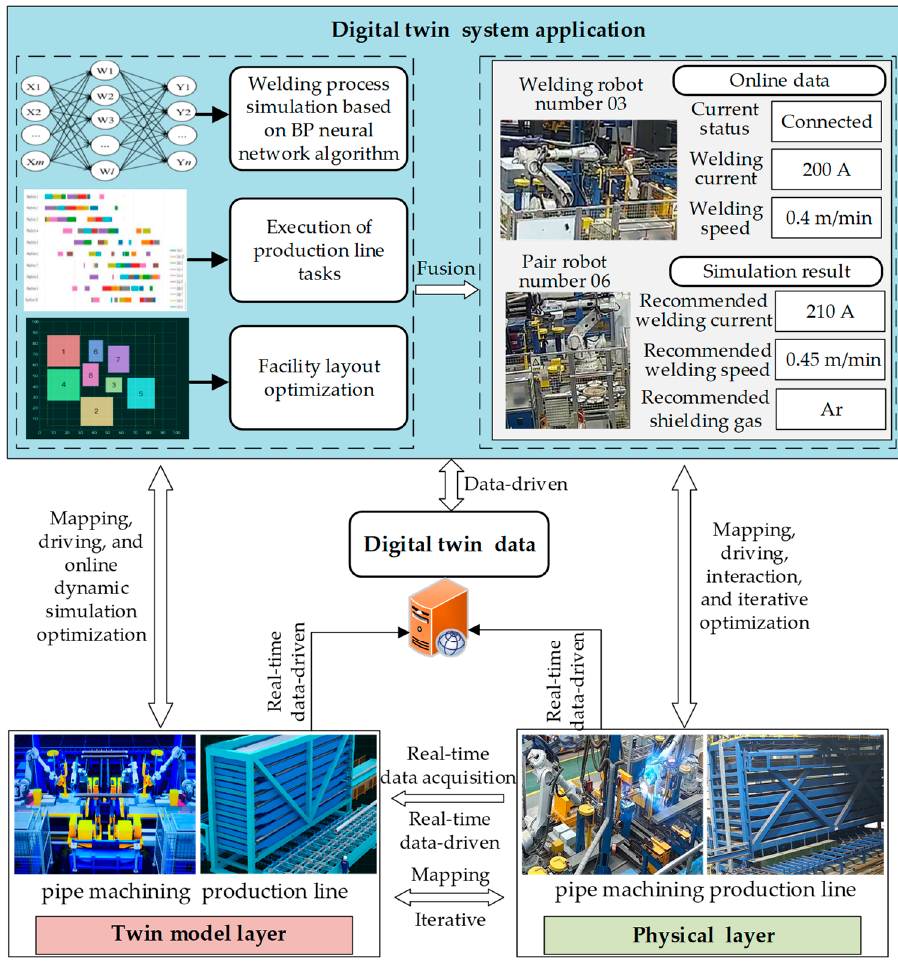
Figure 4. Mapping diagram between digital twin models and physical entity for pipe machining production line of the ship.